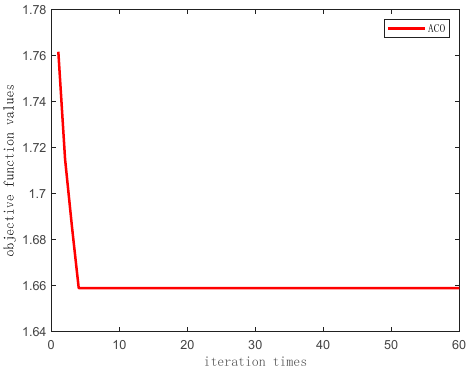
Figure 8. Iterative process diagrams of ACO.